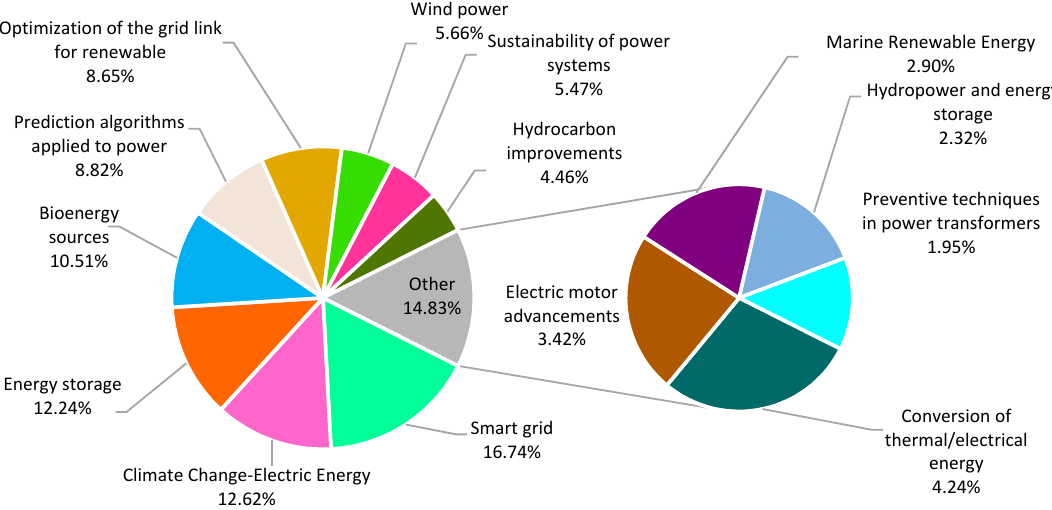
Figure 9. Representation of the distribution of the percentages of communities within Energies .